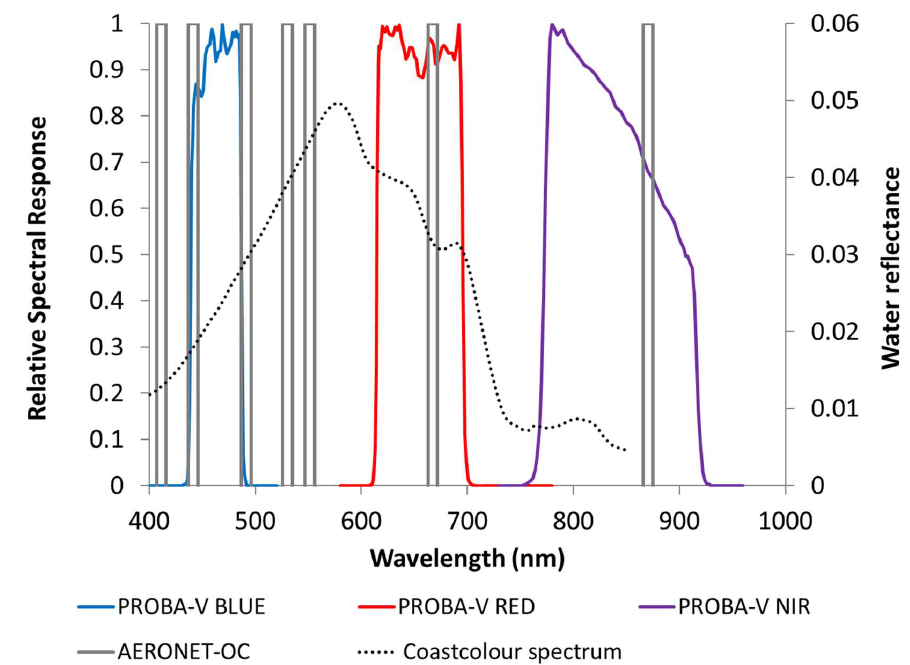
Figure 3. PROBA-V and AERONET spectral bands in 400–1000 nm spectral range. The secondary Y-axis shows a sample in-situ measured hyperspectral ρ w spectrum of the North Sea extracted from the Coastcolour Round Robin dataset [33].